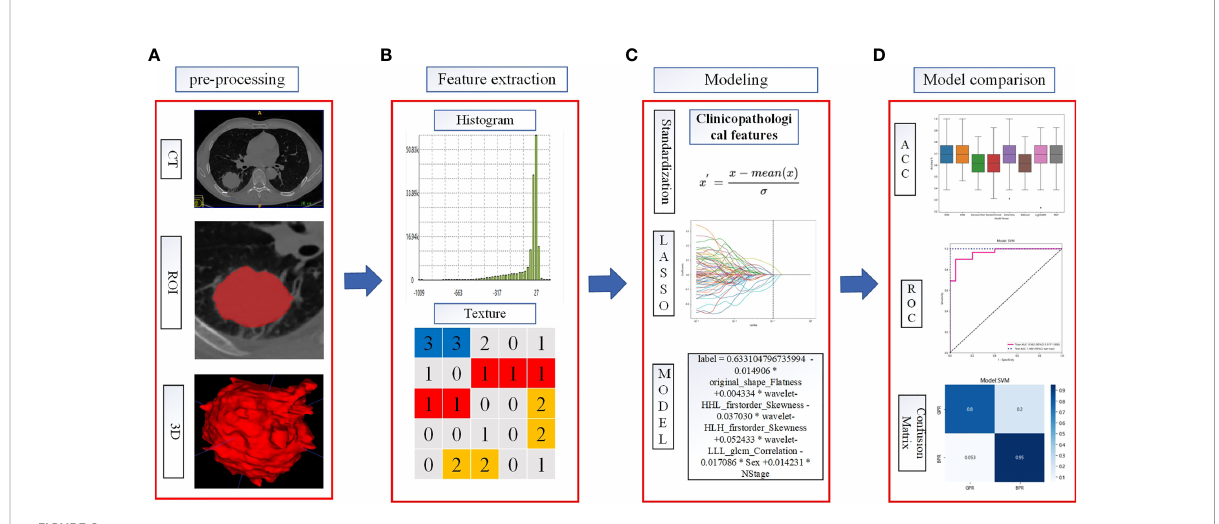
FIGURE 2 Flowchart of radiomics analysis. (A) The ROI was manually segmented on CT images before and after neoadjuvant therapy. (B) Quantitative features in the ROI were calculated, including features such as shape, texture, and wavelet fi ltering. (C) Combined clinicopathological features, standardized processing of data, feature fi ltering, and model building. (D) To evaluate the predictive model ef fi cacy, the evaluation indexes of each model were compared to select the better performing model to construct the before_rad_cil_signature and after_rad_cil_signature. *multiply.